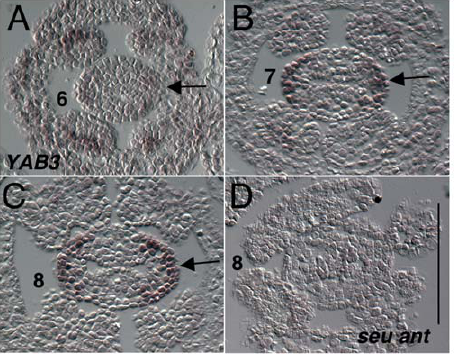
Figure 13. Results of in situ hybridization with BLH11 ( AT1G75430 ) antisense probe. Numbers indicate floral stages. All panels show transverse (cross sectional) tissue orientation. Arrowheads indicate medial domain expression. Arrows indicate valve domain expression. ov - ovule; sp - microsporogenic cells. Scale bars in all panels are 100 microns except for panel A where scale bar is 50 microns. All panels are Col-0 wild type tissue.